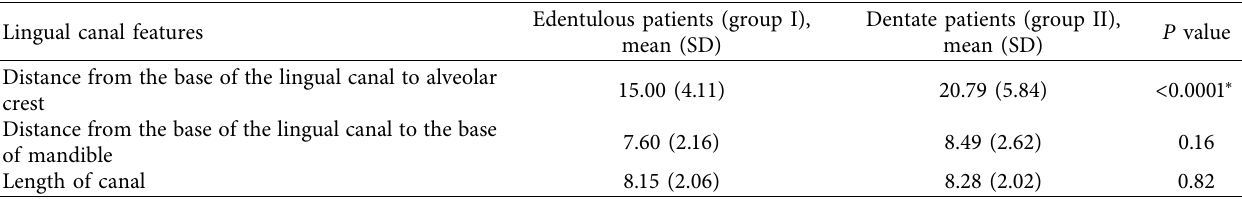
Table 3: Comparison between edentulous and dentate patient regarding lingual canal features.